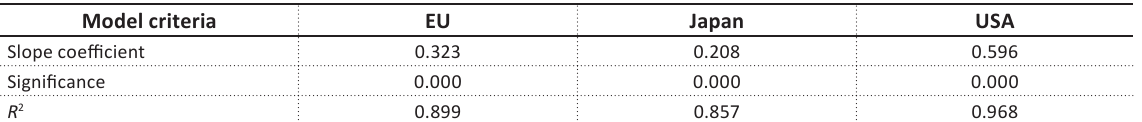
Table 1. Estimation of a long-term